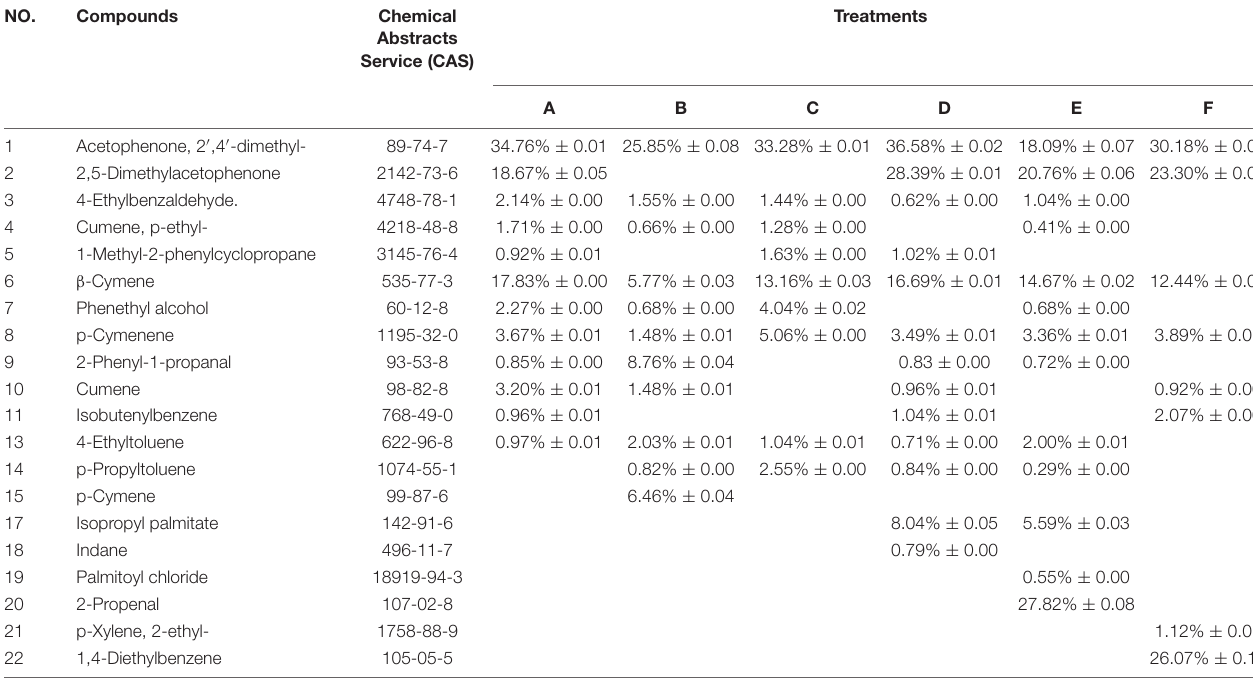
TABLE 1 | The concentration of plant volatile organic compounds in received plants. NO.